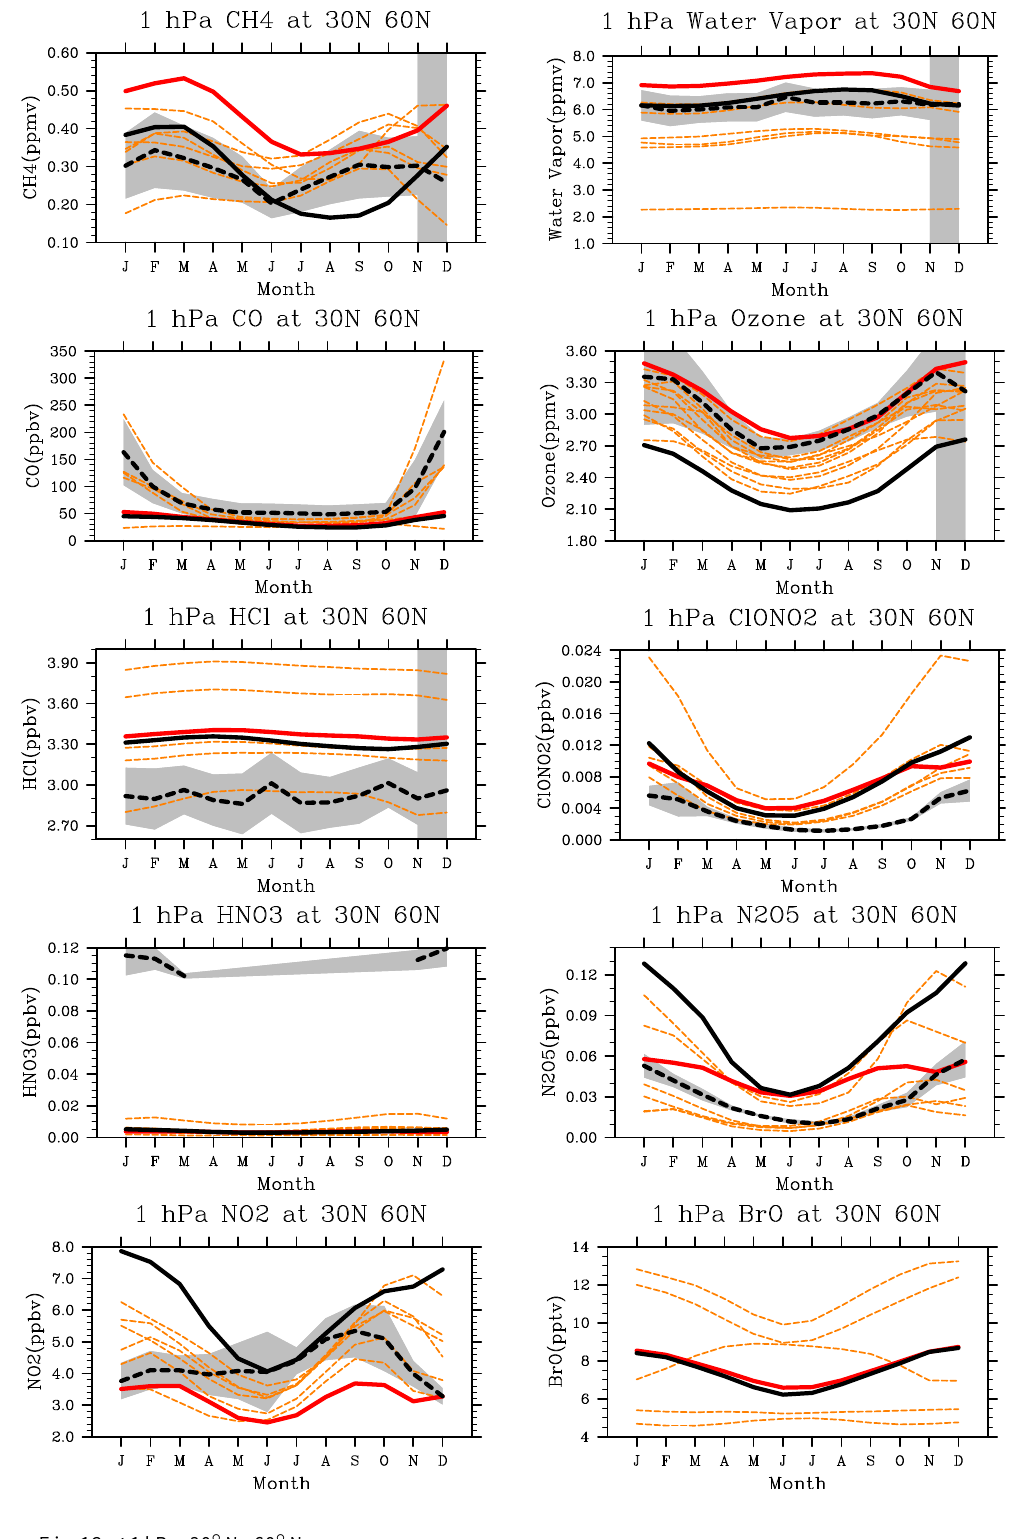
Fig. 15. Same as Fig. 12 at 1 hPa , 30 ◦ N–60 ◦ N.